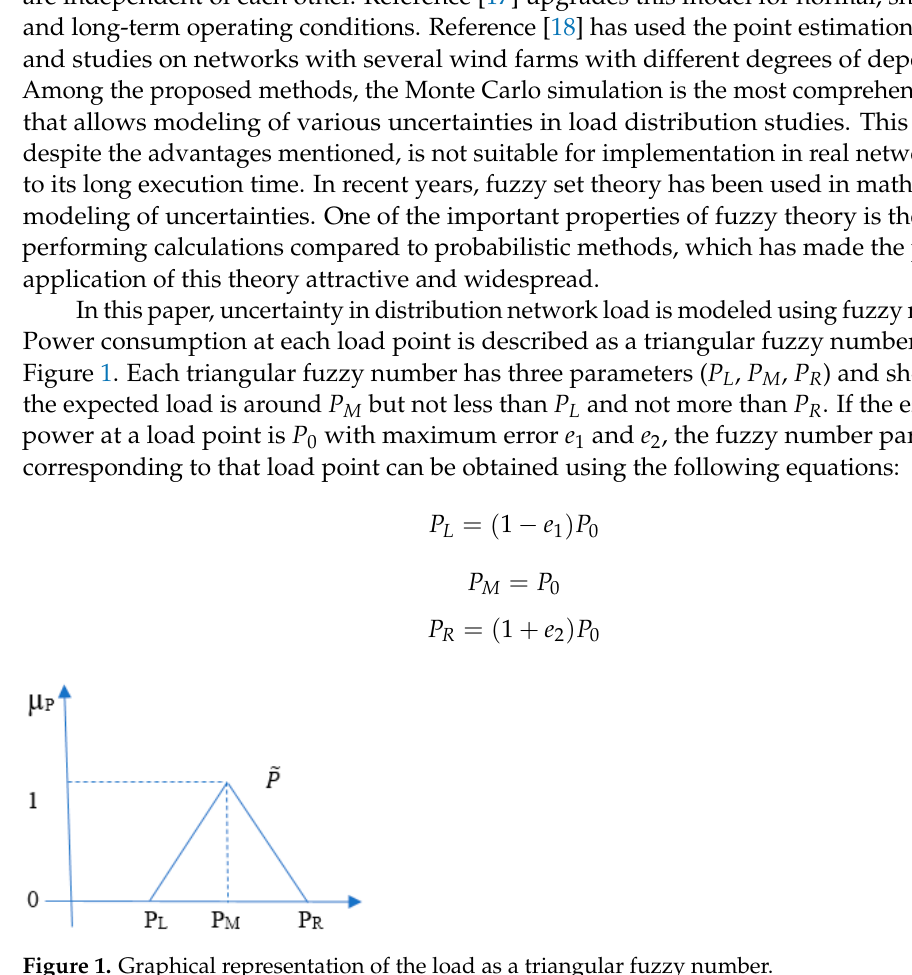
Figure 1. Graphical representation of the load as a triangular fuzzy number.